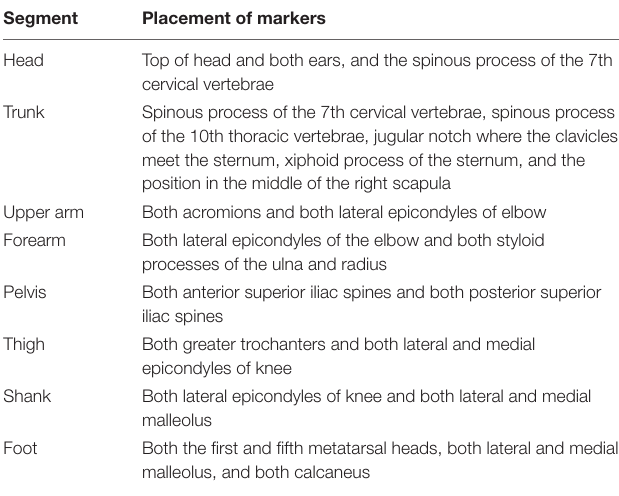
TABLE 2 | Placement of markers on the body. Segment Placement of markers Head Top of head and both ears, and the spinous process of the 7th cervical vertebrae Trunk Spinous process of the 7th cervical vertebrae, spinous process of the 10th thoracic vertebrae, jugular notch where the clavicles meet the sternum, xiphoid process of the sternum, and the position in the middle of the right scapula Upper